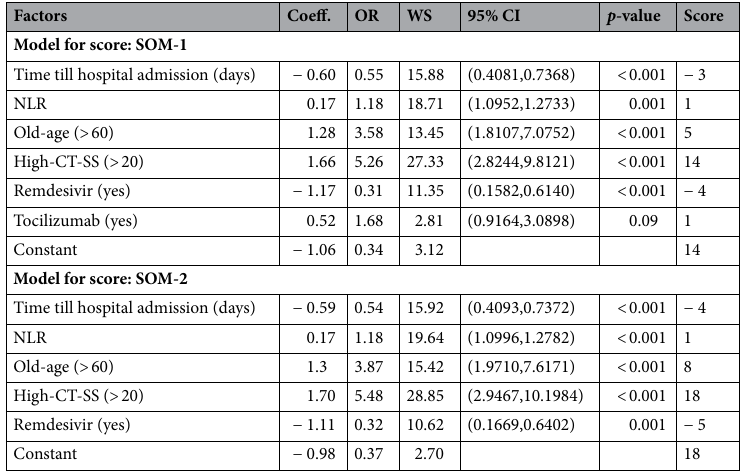
Table 3. Development of scoring system based on best predictors for mortality. Goodness of fit test: Hosmer– Lemeshow, P > 0.05 for all models, coeff: coefficient, OR: Odd ratio, CI: confidence interval, P < 0.05 considered significant, the sign before coefficient number denote the direction of relationship, WS: Wald statistics.